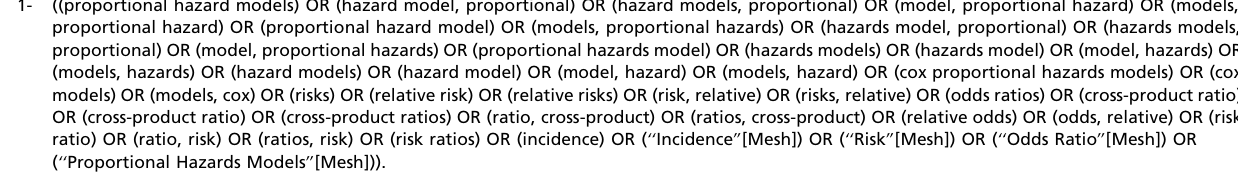
Table S1 - The full search strategy MEDLINE/PUBMED. No Language, article type, or publication date restrictions. 1- ((proportional hazard models) OR (hazard model, proportional) OR (hazard models, proportional) OR (model, proportional hazard) OR (models, proportional hazard) OR (proportional hazard model) OR (models, proportional hazards) OR (hazards model, proportional) OR (hazards models, proportional) OR (model, proportional hazards) OR (proportional hazards model) OR (hazards models) OR (hazards model) OR (model, hazards) OR (models, hazards) OR (hazard models) OR (hazard model) OR (model, hazard) OR (models, hazard) OR (cox proportional hazards models) OR